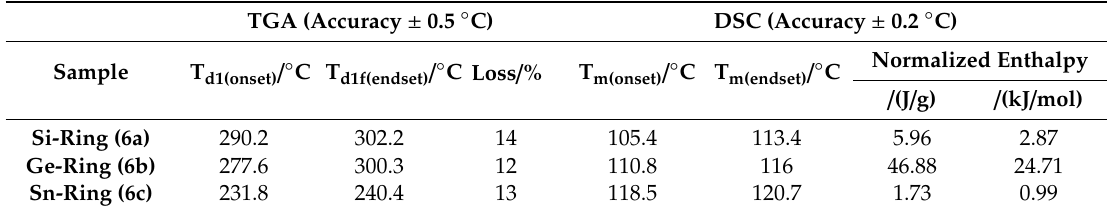
Table 3. Decomposition (T d(onset) , T d(endset) , and percent lost segments), Melting temperatures (T m ) and normalized enthalpy of melting of the rings containing Si ( 9a ), Ge ( 9b ), and Sn ( 9c ).